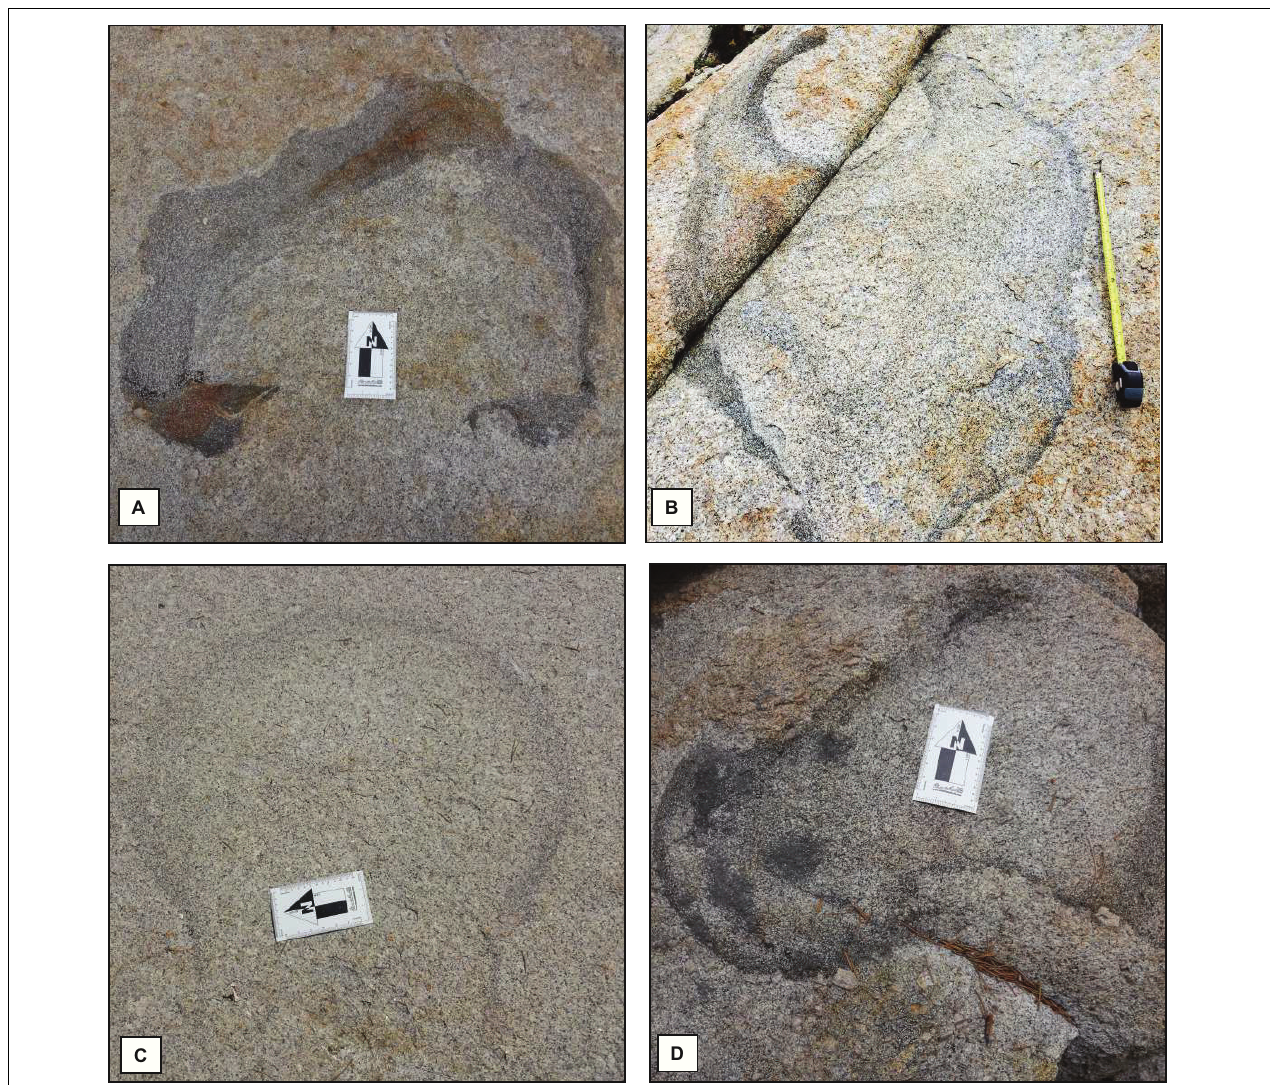
FIGURE 5 | Field photos of plumes. (A) Plume with a ∼ 0.5 m diameter and thick schlieren head, Glen Aulin area. The thickness of the schlieren varies around the margins of the plume, is sharpest at the contact with host CP, and more diffuse towards the interior. (B) ∼ 1 m wide plume head, Young Lakes area. As in panel (A) , the schlieren is sharpest at the contact with host CP and is diffuse towards the interior. The plume is re-intruded by host CP. (C) Diffuse plume with tail preserved, Lyell Canyon area. This diffuse type of schlieren is common in the central regions of the CP unit (see also Pothole Dome area; Paterson, 2009). (D) Plume with well-defined head and elongate tail. The interior of this plume has a clear compositional difference with the surrounding host